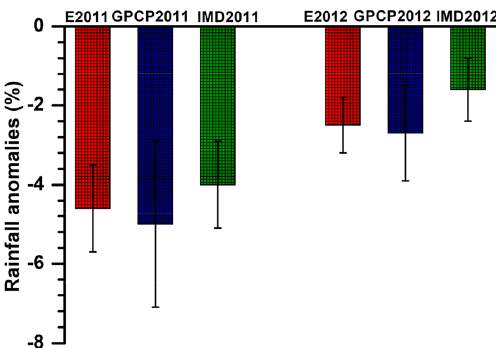
Figure 4. Distribution of anomalies (Vol-CTL) of rainfall (%) (averaged for 78–93°E, 8–35°N and for monsoon 2011 (July–September) and monsoon 2012 (June–September) from MPI-ESM represented as E2011, E2012; Global Precipitation Climatology Project (GPCP) (precipitation of monsoon 2011/2012—climatology of 1981–2015), India Meteorology Department (IMD) data (precipitation of monsoon 2011/2012—climatology of 1950–2015) (Figure created using Origin (OriginLab, Northampton, MA)).